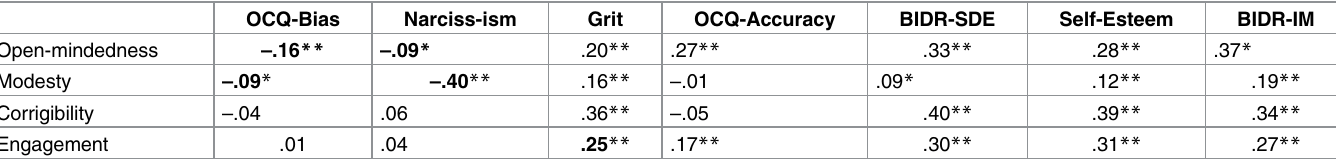
Table 9. Correlations between IH scalesand related